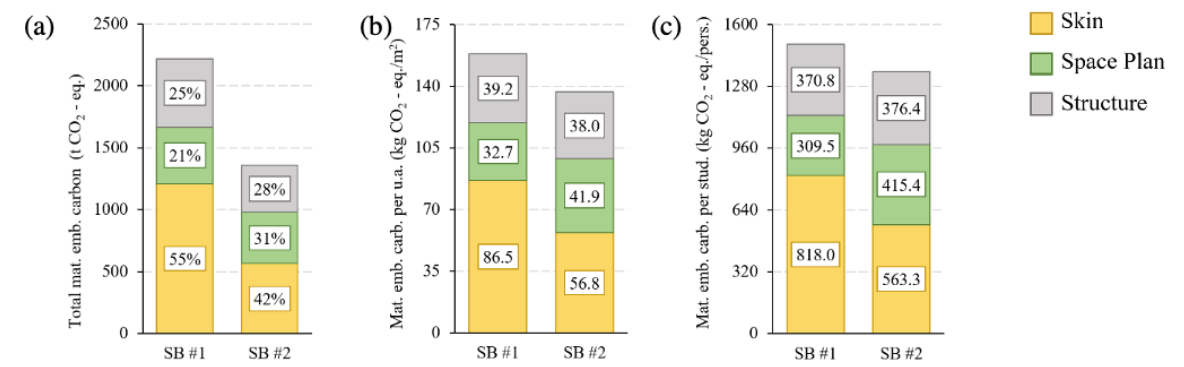
Figure 2. Embodied carbon of building materials grouped into macro-layers: (a) total amount; (b) amount per unit of gross building area (u.a.); (c) amount per student.